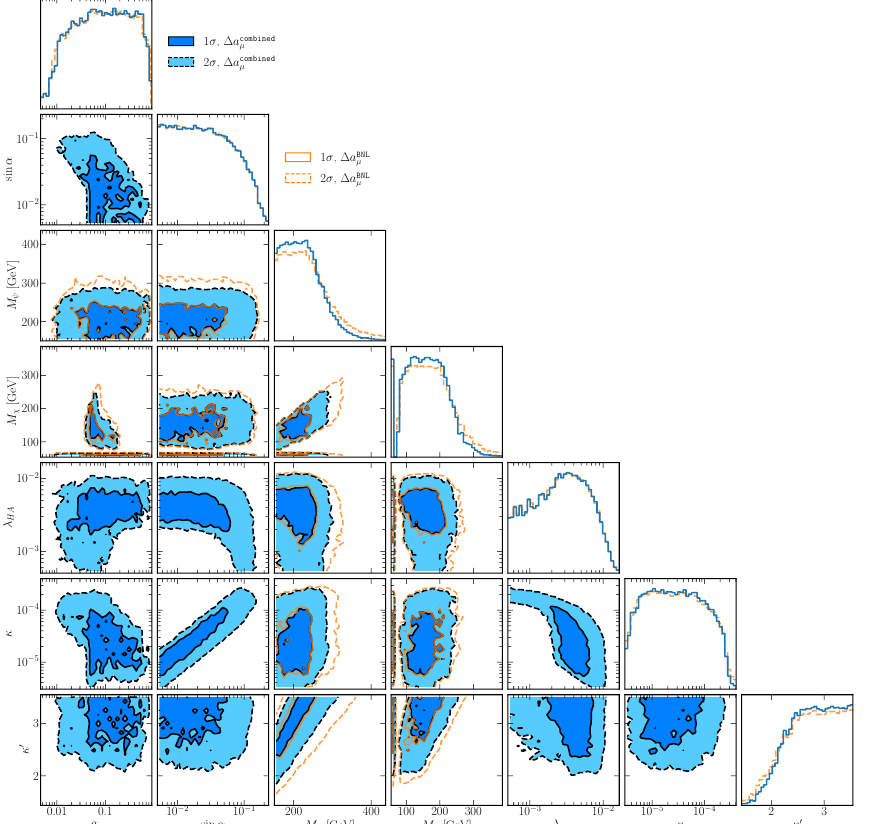
Figure 7 . The likelihood distribution among seven scan parameters: g χ , sin α , M ψ , M χ , λ HA , κ , κ 0 in our global analysis. The 1 σ and 2 σ contours corresponding to using the ( g − 2) µ from the E821 experiment at BNL are shown in orange, only when the change is